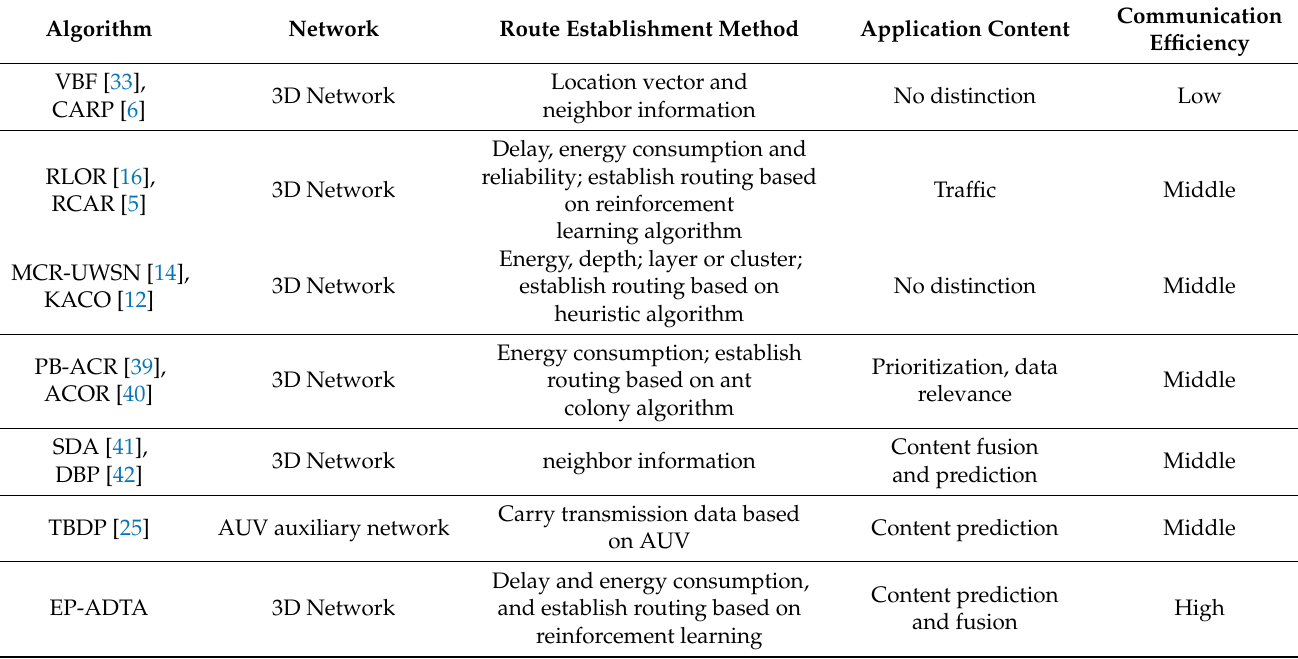
Table 1. Several typical routing protocols for underwater wireless sensor